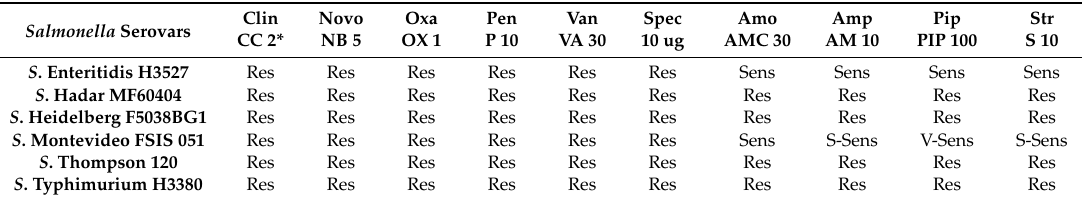
Table 1. Antibiotic disc assay of select Salmonella serovars showing multidrug resistance (Res, resistant; Sens, sensitive; S-sens, slightly sensitive; V-sens, very sensitive). Salmonella Serovars